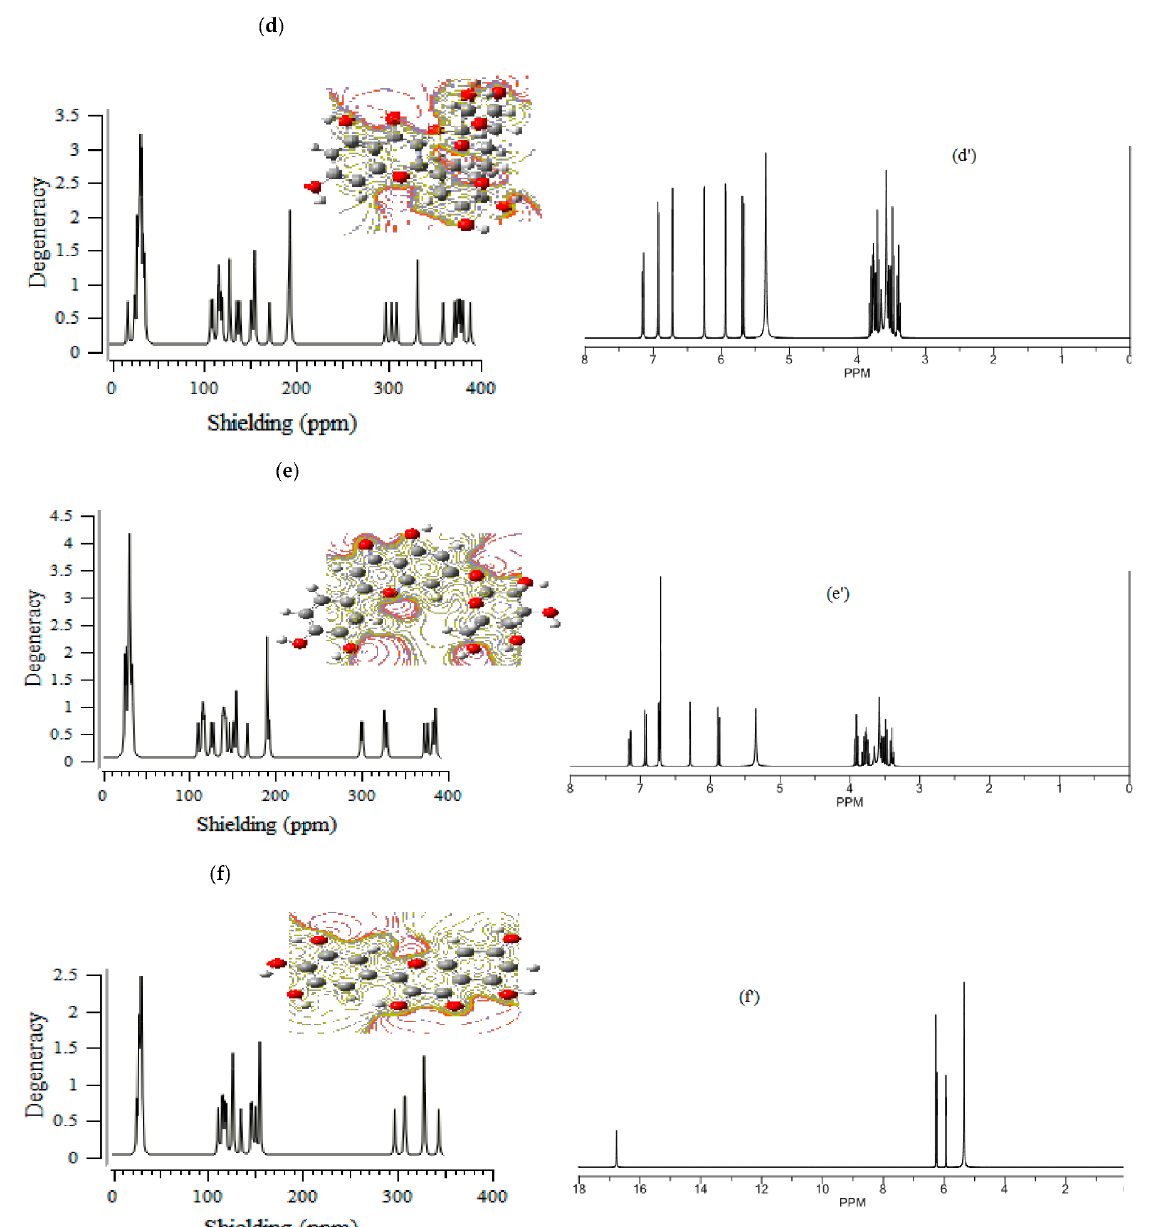
Figure 1. The graph of NMR spectra of isotropic ( σ iso ), anisotropic ( σ aniso ) shielding tensors calculated by level of theory B3LYP/6-311+G(2d,p) for ( a ) (+)-catechin, ( a’ ) (+)-catechin → CNT, ( b ) betulinic acid, ( b’ ) betulinic acid → CNT, ( c ) ursolic acid, ( c’ ) ursolic acid → CNT, ( d ) quercetin-3-O-galactoside, ( d’ ) quercetin-3-O-galactoside → CNT, ( e ) luteolin-7-O-glucoside, ( e’ ) luteolin-7-O-glucoside → CNT, ( f ) myricetin and ( f’ ) myricetin → CNT.